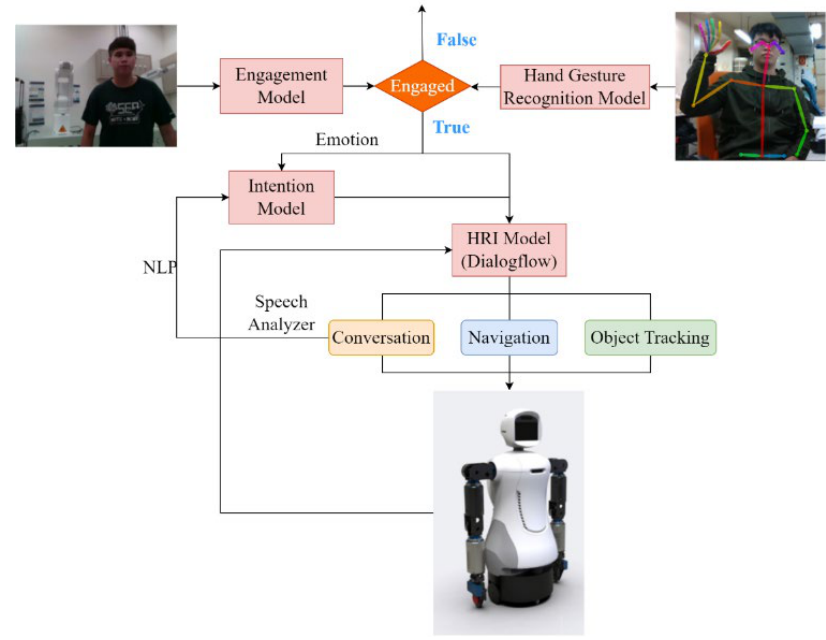
Figure 1. The robot’s cognitive system.